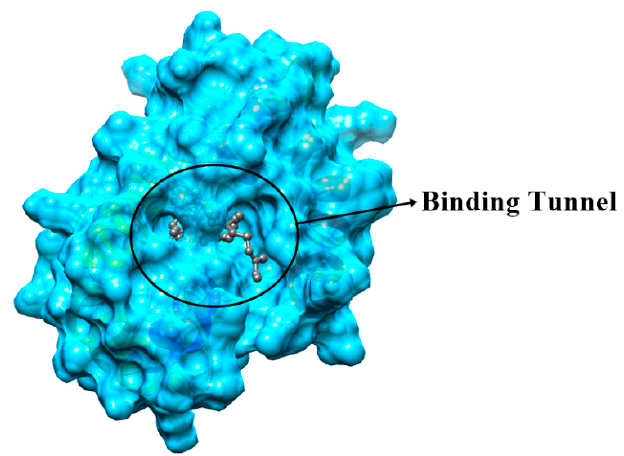
Figure 8. Conserved binding cavity of SaveOBP9, and the variety of bindings observed between chemicals and receptors. The circle in the cavity represents the conserved binding tunnel. Table 2. Docking score and molecular docking results of particular ligands.